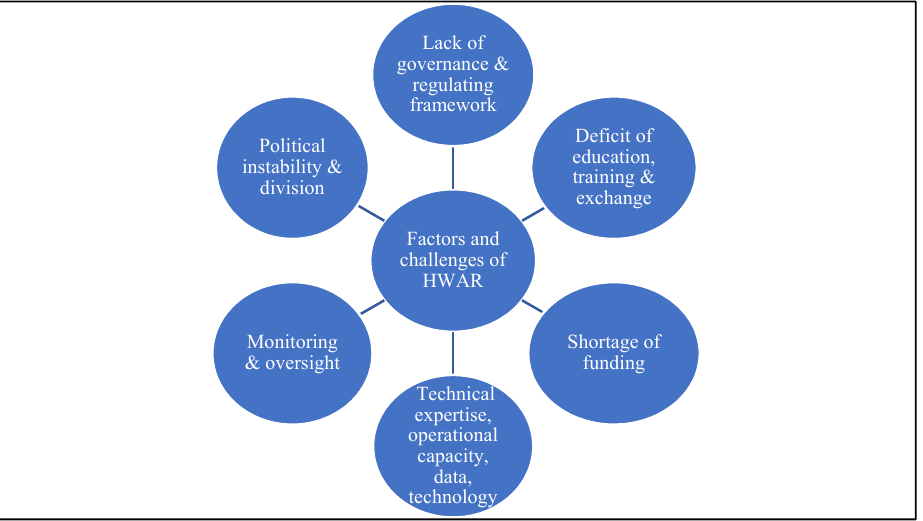
Figure 1. HWAR challenges and gaps.